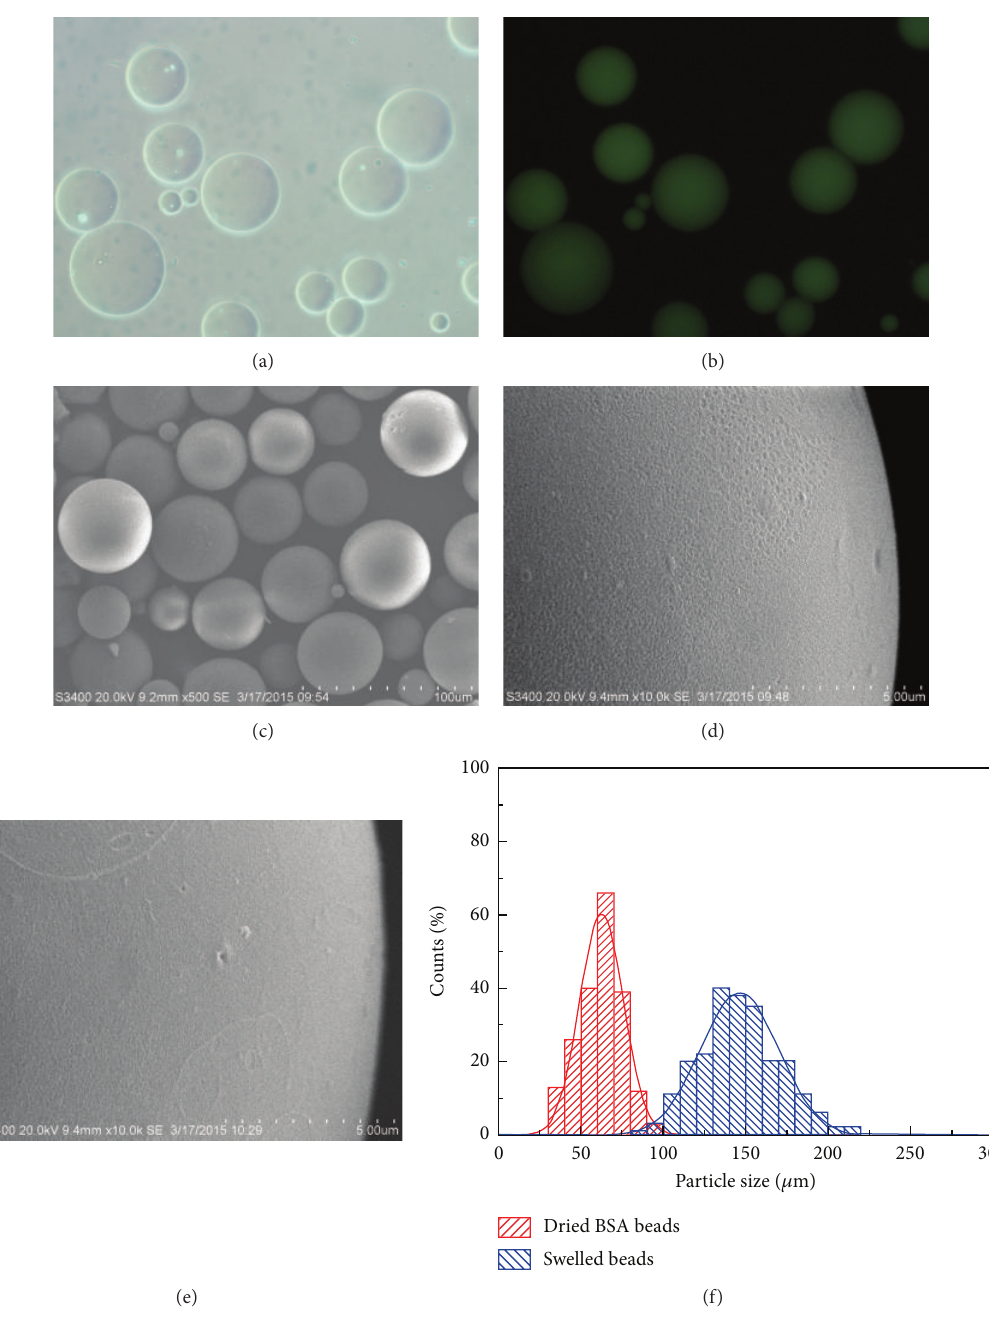
Figure 1: Morphologies and size distributions of BSA beads and irinotecan loaded BSA beads. (a) Water-swelled cross-linked BSA beads with magnification of 200x under bright field optical microscope; (b) the same beads as (a) under dark field fluorescence microscope; (c) SEM images of dried cross-linked BSA beads with magnification of 500x; (d) surface morphology image of dried cross-linked BSA beads with magnification of 10000x under SEM; (e) surface morphology image of irinotecan loaded dried BSA beads with magnification of 10000x under SEM; and (f) size distribution of dried BSA beads and swelled BSA